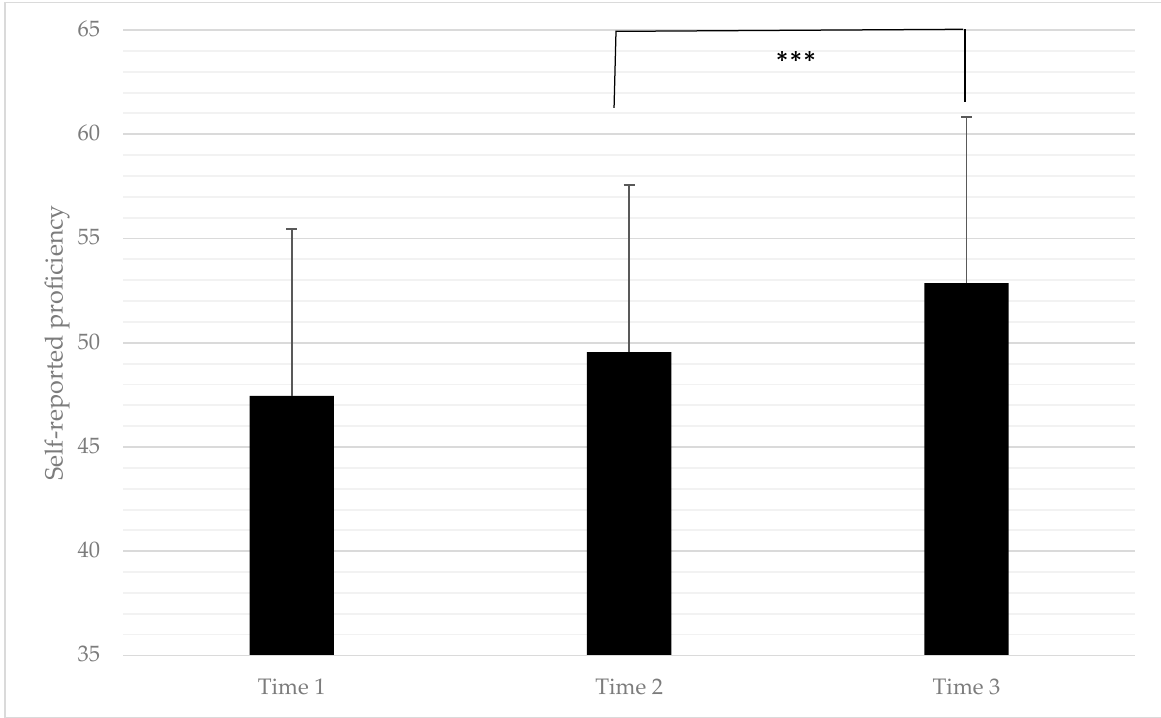
Figure 4. Self-reported proficiency scores from Time 1 to Time 3 (*** p < 0.001).